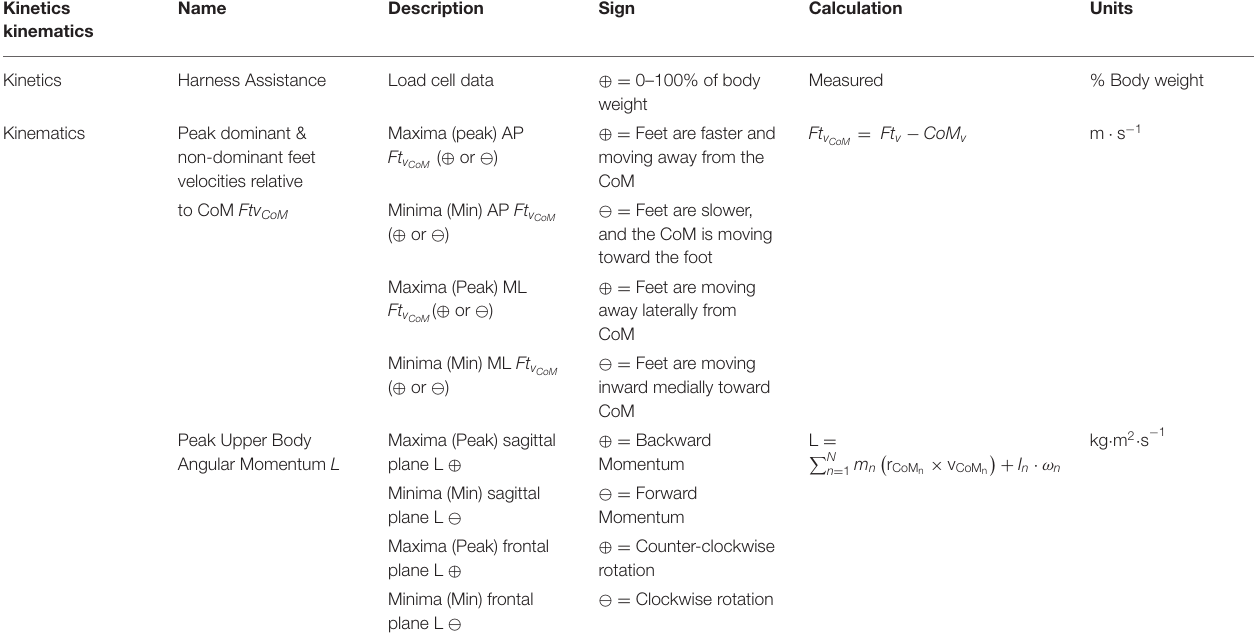
TABLE 2 | Analyzed biomechanical